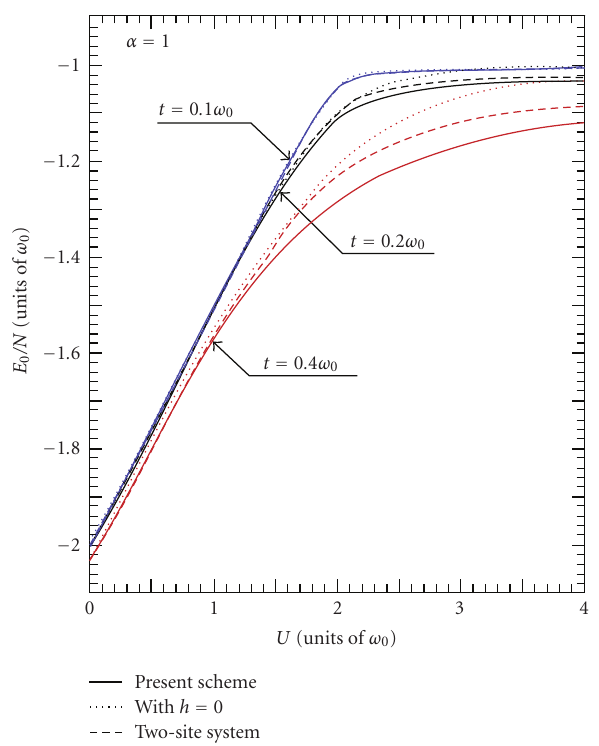
Figure 1: (Color online) Ground-state energy per site as a function of U for α = 1 and three cases of t/ω 0 = 0 . 1, 0.2, and